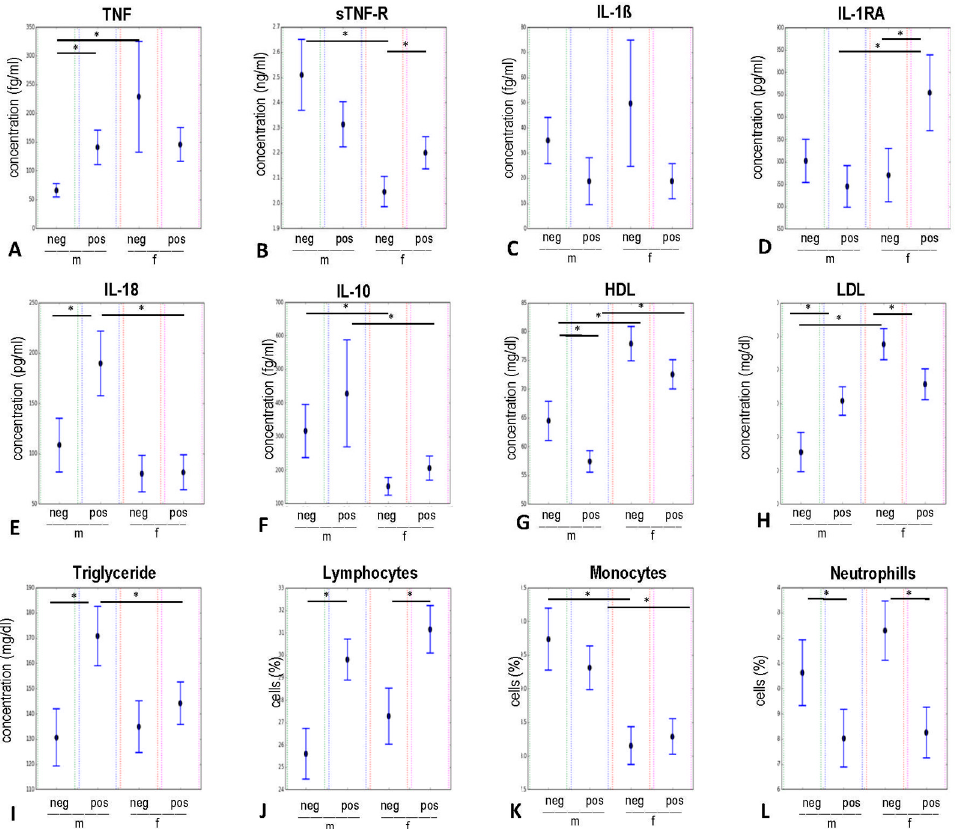
Figure 3. Bootstrapping results on the influence of CMV-serostatus and gender on circulating pro- and anti-inflammatory cytokines, receptor antagonist, immune cells, and metabolic factors. Data are presented as means with 95% confidence intervals for CMV-negative and CMV-positive males as well as for CMV-negative and CMV-positive females. * p < 0.05. IL-1 β : interleukin 1 beta; IL-1RA: interleukin 1 receptor antagonist; TNF: tumor necrosis factor; sTNF-R: soluble tumor necrosis factor receptor; IL: interleukin; HDL: high-density lipoprotein; LDL: low-density lipoprotein; m: male; f: female; pos: CMV-seropositive; neg: CMV-seronegative.